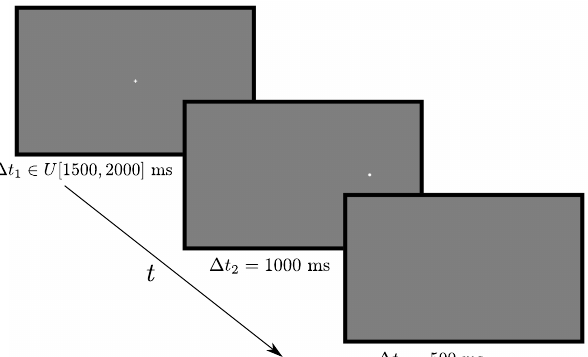
Figure 2 . Time course of an antisaccade